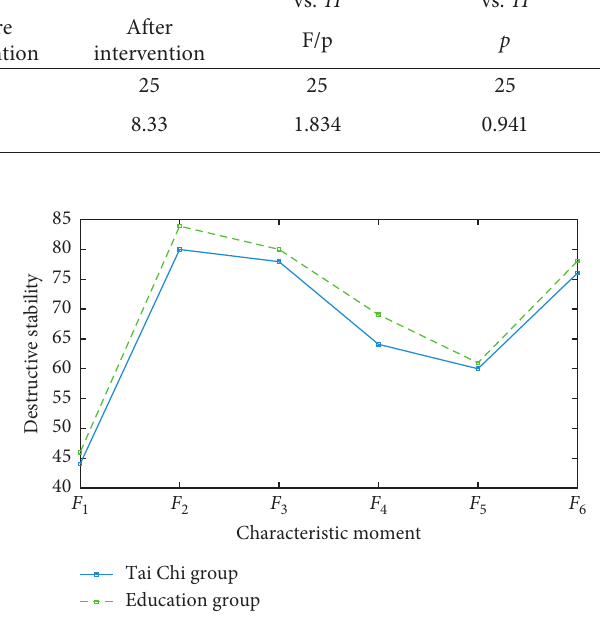
Figure 4: The value of the destabilizing before and after the